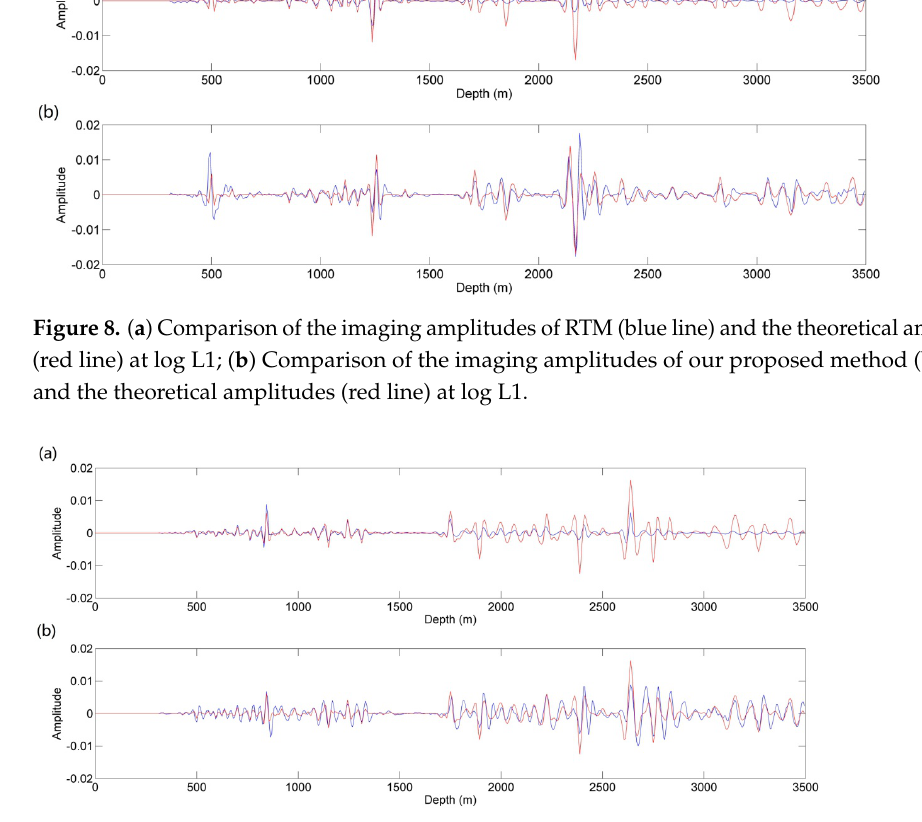
Figure 9. ( a ) Comparison of the imaging amplitudes of RTM (blue line) and the theoretical amplitudes (red line) at log L2; ( b ) Comparison of the imaging amplitudes of our proposed method (blue line) and the theoretical amplitudes (red line) at log L2.